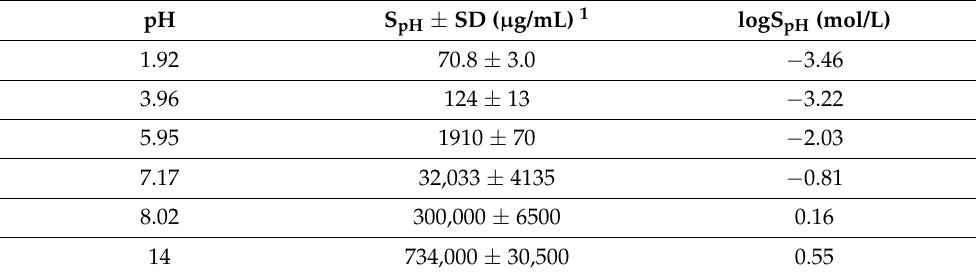
Table 3. The pH-dependent equilibrium solubility of ibuprofen at 37 °C.